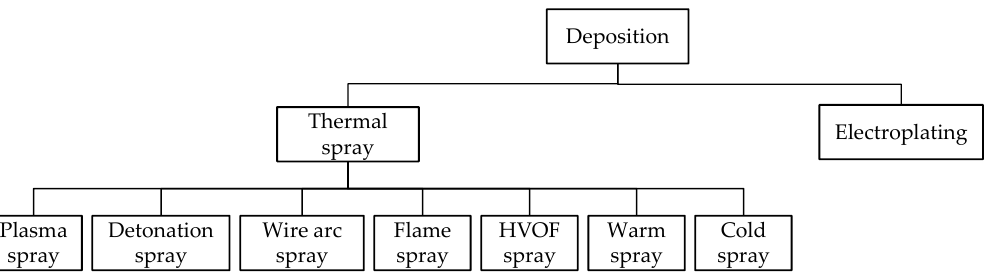
Figure 8. Kind of deposition of a low friction coating [19].